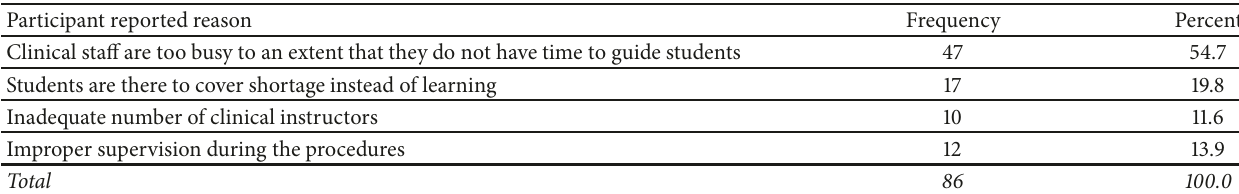
Table 7: Reasons on how shortage of staff affects clinical learning (n=86).